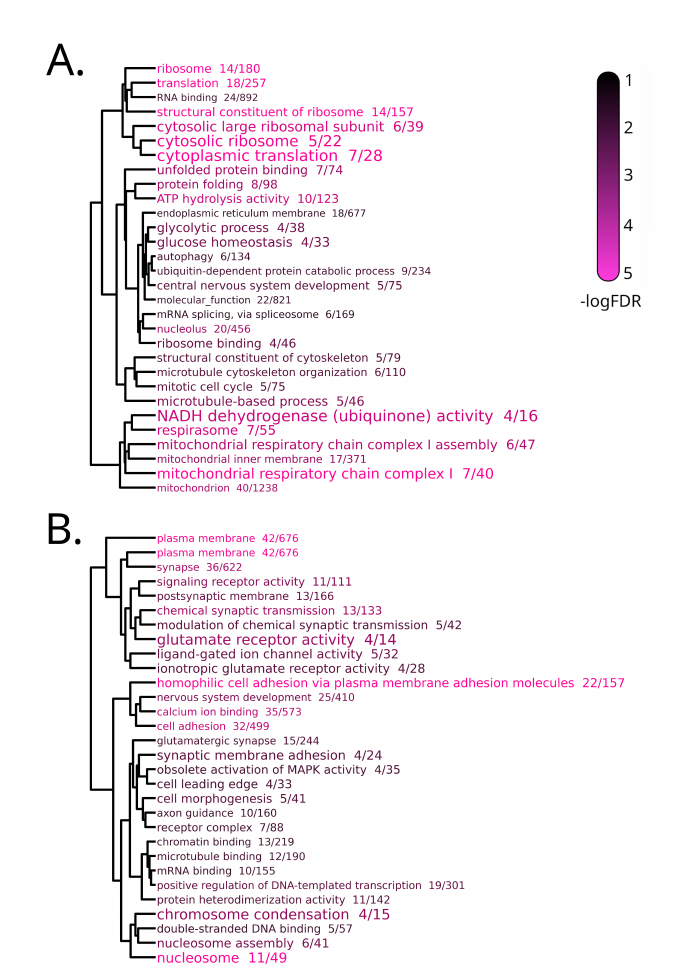
Figure 3. Dendrogram representation of complete linkage of overlapping downregulated ( A ) and upregulated ( B ) DEGs associated with the top 30 most significantly enriched GO terms in the Stressed vs. Control comparison of the Brain sample at T3. The size of the GO terms codes for the observed/expected value, the color scale for statistical significance.